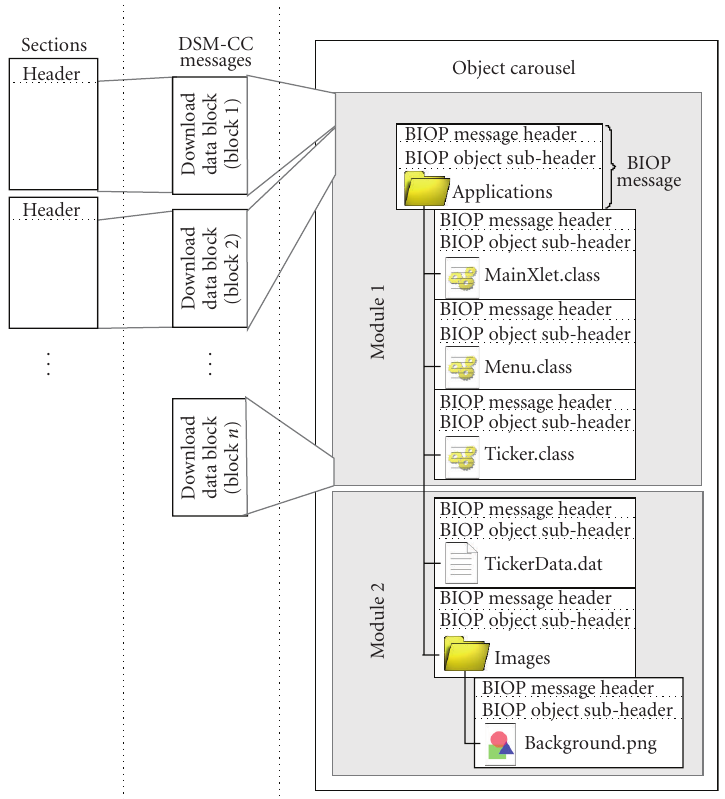
Figure 3: Interactive data format in DVB-MHP.